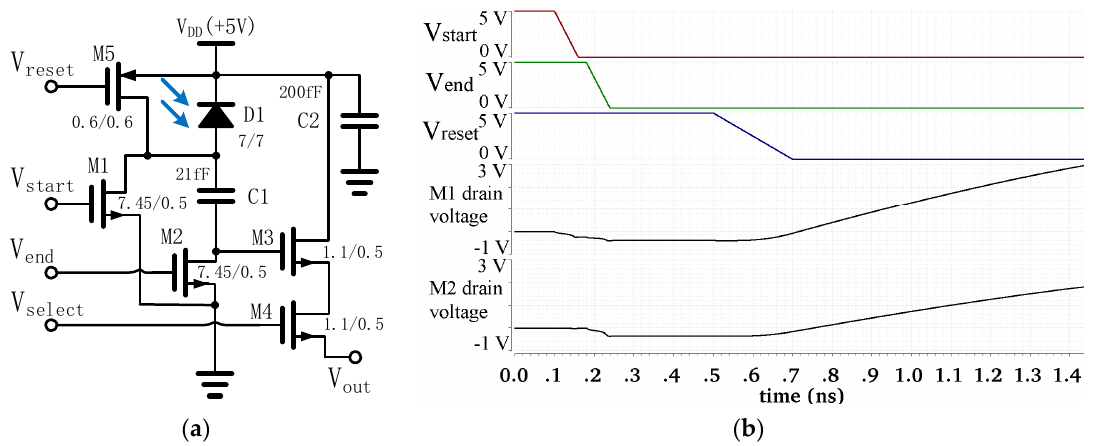
Figure 2. ( a ) The pixel circuit schematic; ( b ) The timing chart of the pixel and the simulated results of the drain voltage of M1 and M2.